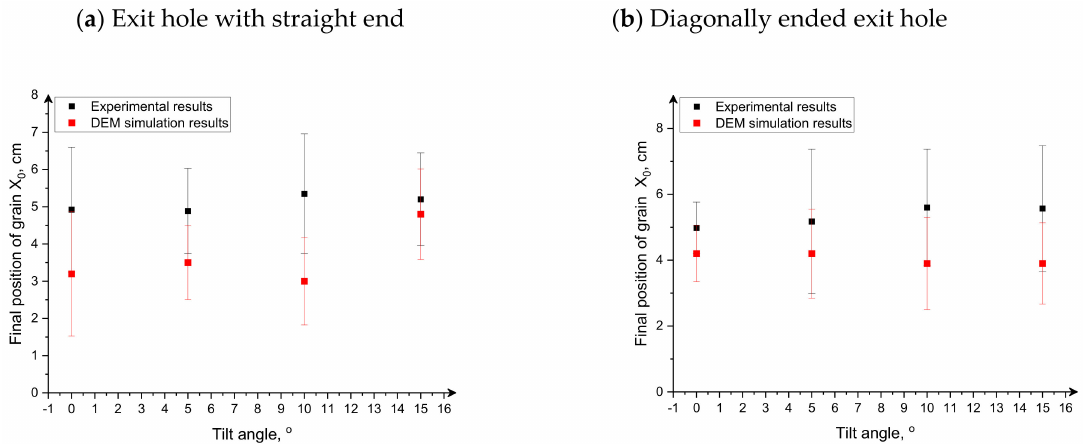
Figure 11. Final position of grain X 0 after collision for different tilt angles during experimental and simulation